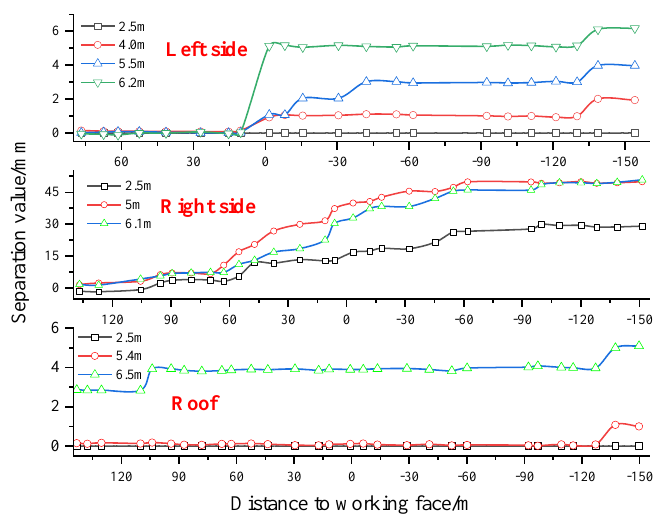
Figure 22. Surrounding rock separation near measuring point 11#.